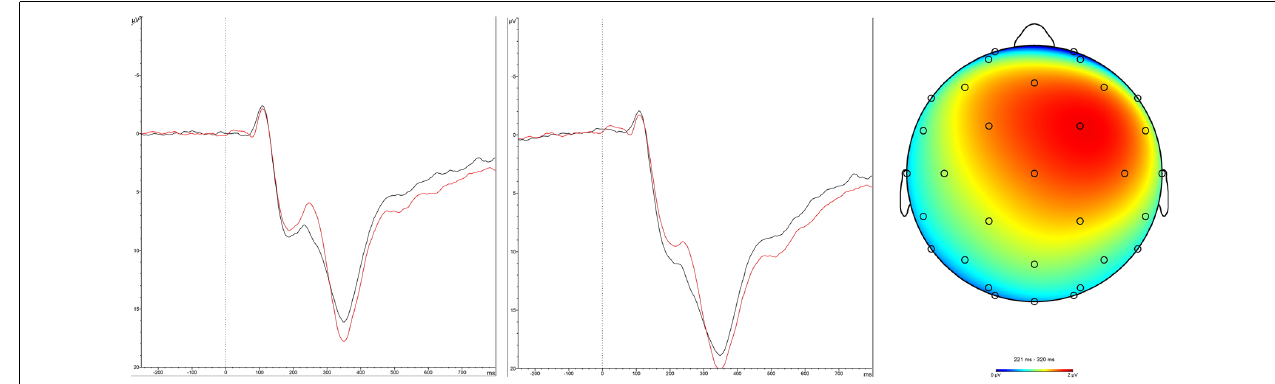
FIGURE 2 | The left-most panel shows the feedback-locked ERPs at Fz for rewards (black) and losses (red). The RewP occurs 220–320 ms after feedback onset (0 on the horizontal axis). The middle panel shows the same event-related potentials (ERP) at Cz. The right-most panel displays the topographic maps of the RewP difference wave, showing that it peaked over frontal-central